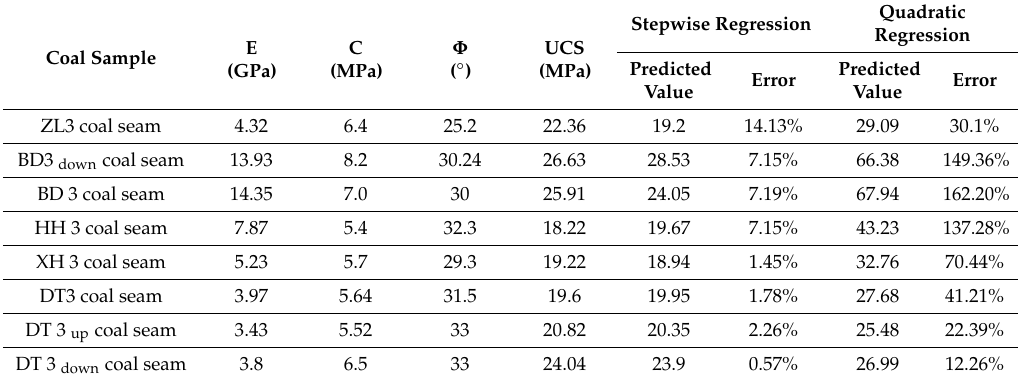
Quadratic Stepwise Regression